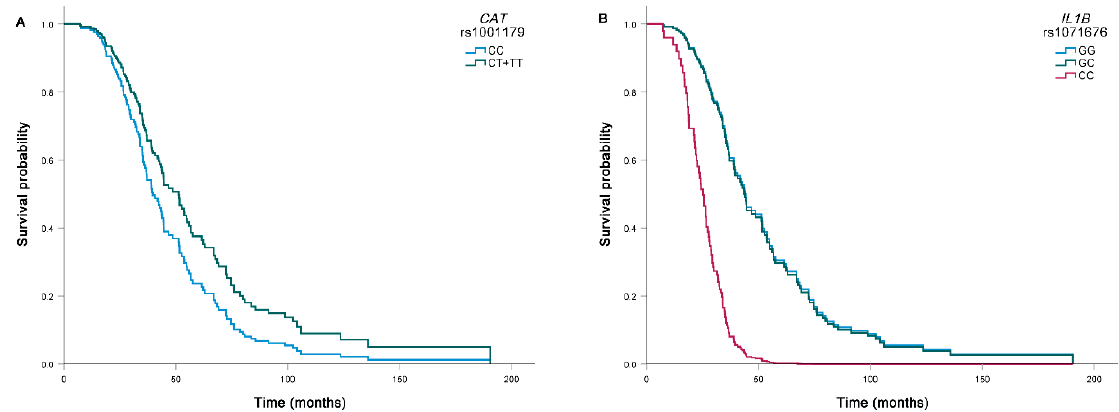
Figure 2. Association of CAT rs1001179 ( A ) and IL1B rs1071676 ( B ) with survival of ALS patients. Carriers of at least one polymorphic CAT rs1001179 T allele had longer survival after adjustment for age at onset and rate of disease progression (HR = 0.68, 95% CI = 0.47–0.99, p = 0.046). Carriers of two polymorphic IL1B rs1071676 C alleles had shorter survival after adjustment for age at onset and rate of disease progression (HR = 5.02, 95% CI = 1.92–13.16, p = 0.001).